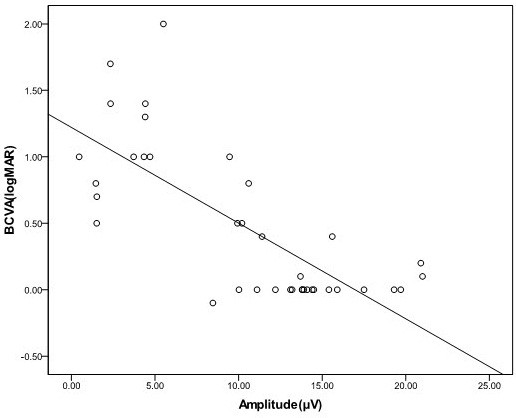
The correlation between amplitude and visual acuity of normal and amblyopic eyes in pattern VEP. Pattern amplitude is plotted as a function of visual acuity. The solid line represents the linear regression line fit the data (y = -0.072x + 1.22), and it was statistically significant with p < 0.0001.